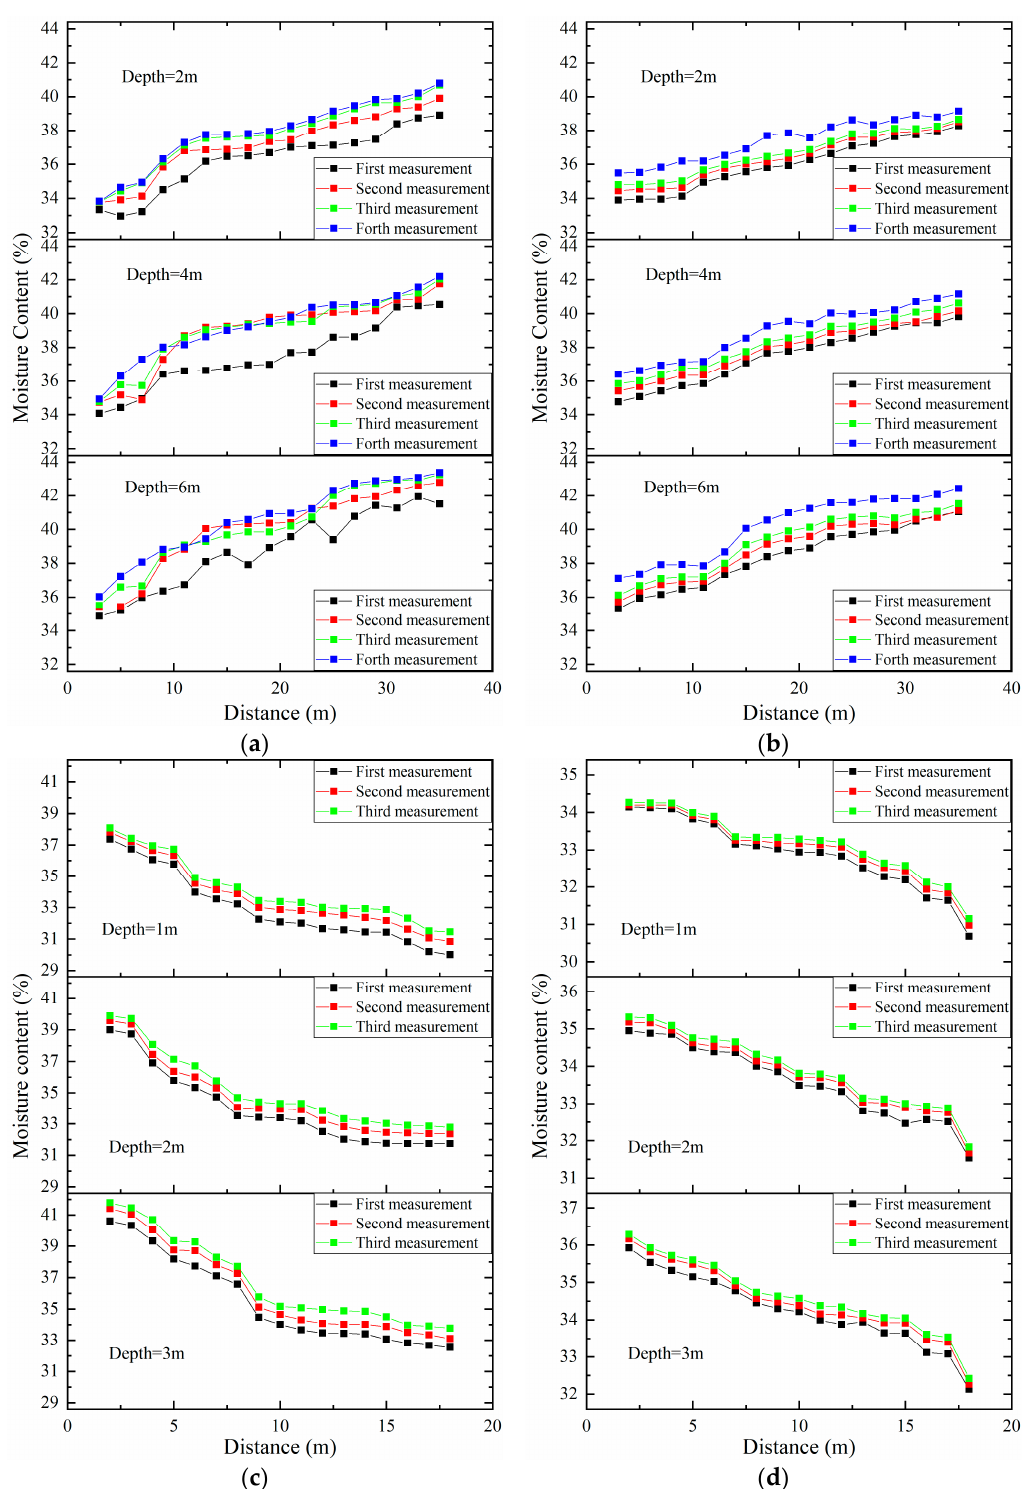
Figure 18. Results of water content inversion: ( a ) survey line 1; ( b ) survey line 2; ( c ) survey line 3; ( d ) survey line 4.